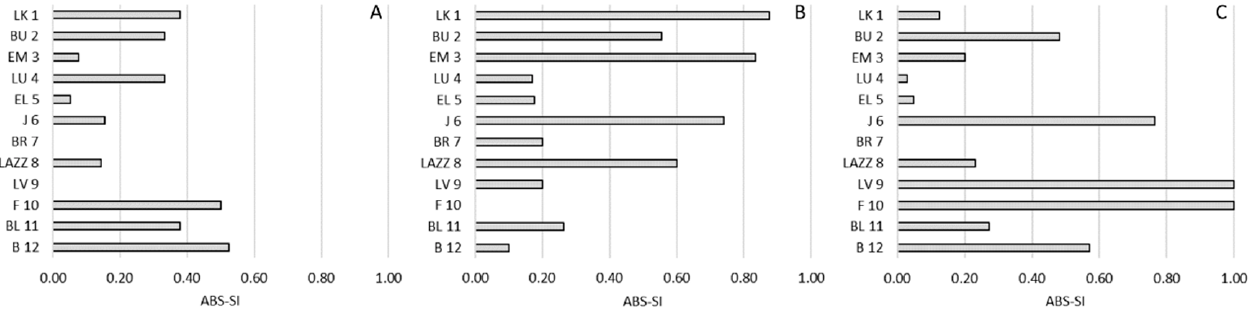
Figure 7. Strength of the bias of transversality preference (ABS-TI) and social hierarchy in Barbary macaques . Individuals (y-axis) are presented according to their social rank from 1 (the most dominant macaque) to 12 (the most dominated macaque), based on the CBI. ( A ): approach; ( B ): proximity; ( C ): affiliative contacts.